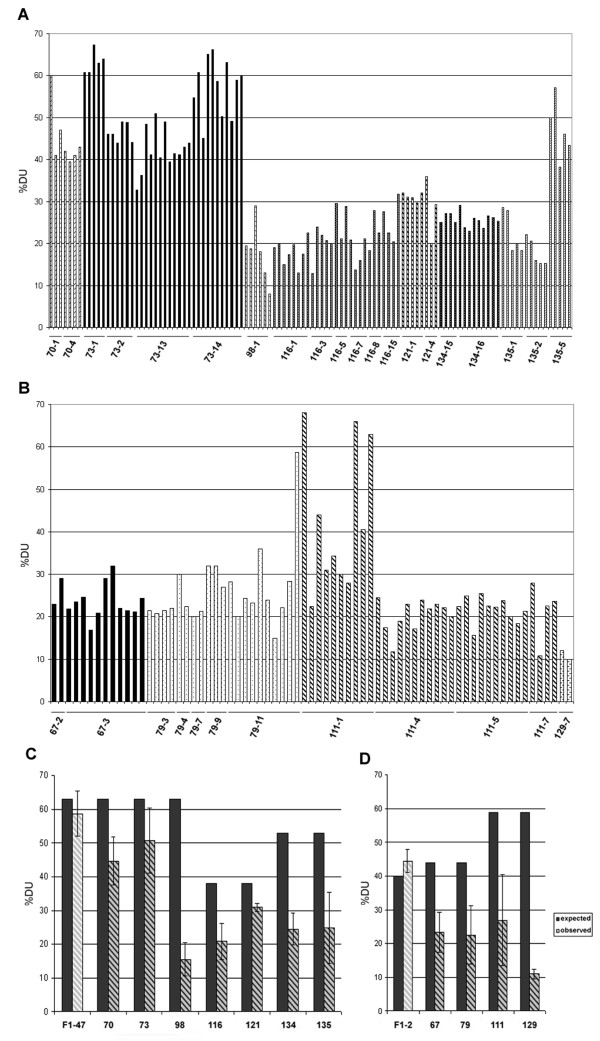
Summary of rDNA repeat ratios analysis estimated for individual synthetic T. mirus (A, C) and T. miscellus (B, D) plants. Homeolog gene ratios were determined from quantification of band signals after the Southern blot hybridization (Figures 2, 3). Each parental hybridization band was quantified using phosphorimaging, and gene ratios were expressed as a percentage of T. dubius units out of the total signal (A, B). The averaged values for each line are shown in graphs (C and D - shaded bars); for F1 diploid hybrids the shaded bars are drawn at low contrast. Filled bars represent expected gene ratios based on strict Mendelian inheritance of gene copy numbers. The interindividual variability within the line is expressed by standard deviation from the mean. Differences between expected and observed ratios were highly significant (P < 0.001, standard chi-square test) in all lines except the diploid F1-47 and F1-2 hybrids and line 121.